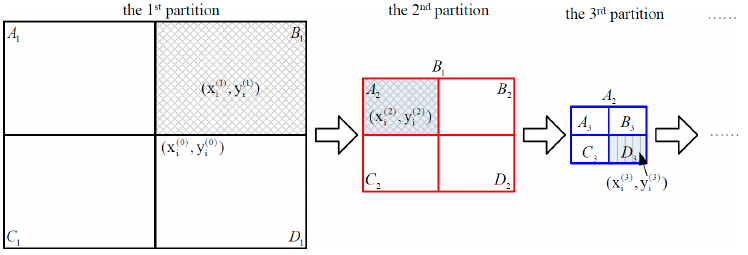
Figure 2. Schematic diagram of iterative partitioning of a grid.